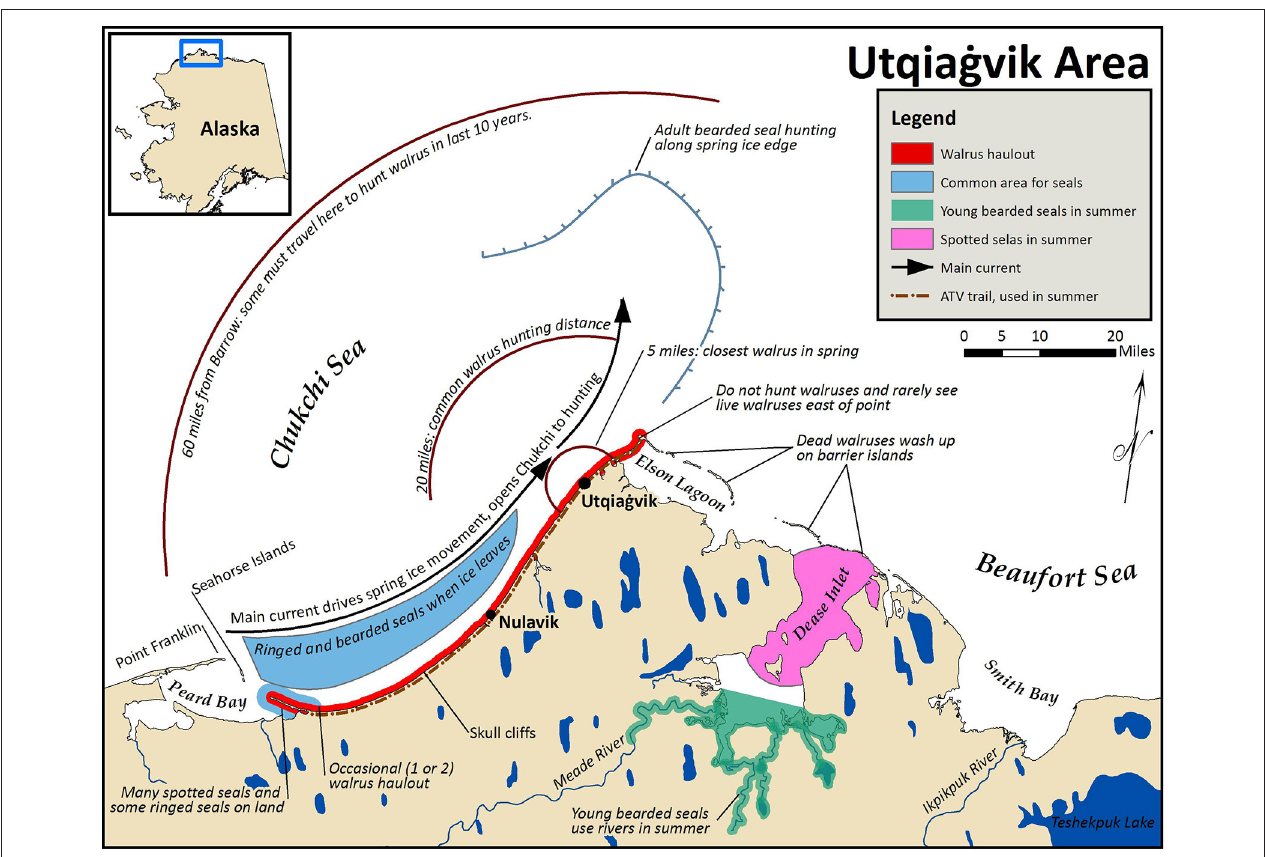
FIGURE 2 | Traditional knowledge about the movements and behavior of marine mammals near Utqia˙gvik (formerly Barrow), Alaska as described during interviews in January 2015.